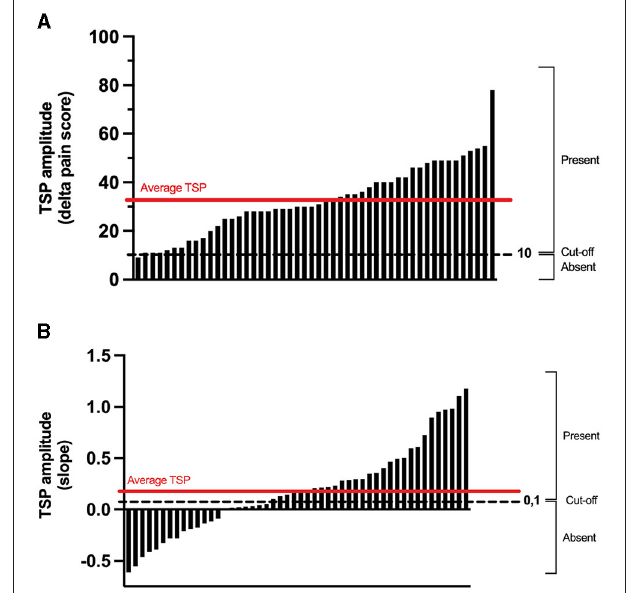
FIGURE 4 | Individual TSP obtained during the pre-CS TS in the TENS protocol (A) and in the thermode/CPT protocol (B) . For TSP in the TENS protocol (calculated as the delta in pain scores between 5Hz stimulation and 1Hz stimulation), a delta pain score larger than 10 percentage points was classified as “TSP present.” As for the TSP in the thermode/CPT protocol (calculated as the slope of the linear regression of the pain scores throughout the TS), a slope larger than 0.1 was classified as “TSP present.” CPT, cold pressor test; TENS, transcutaneous electrical nerve stimulation;